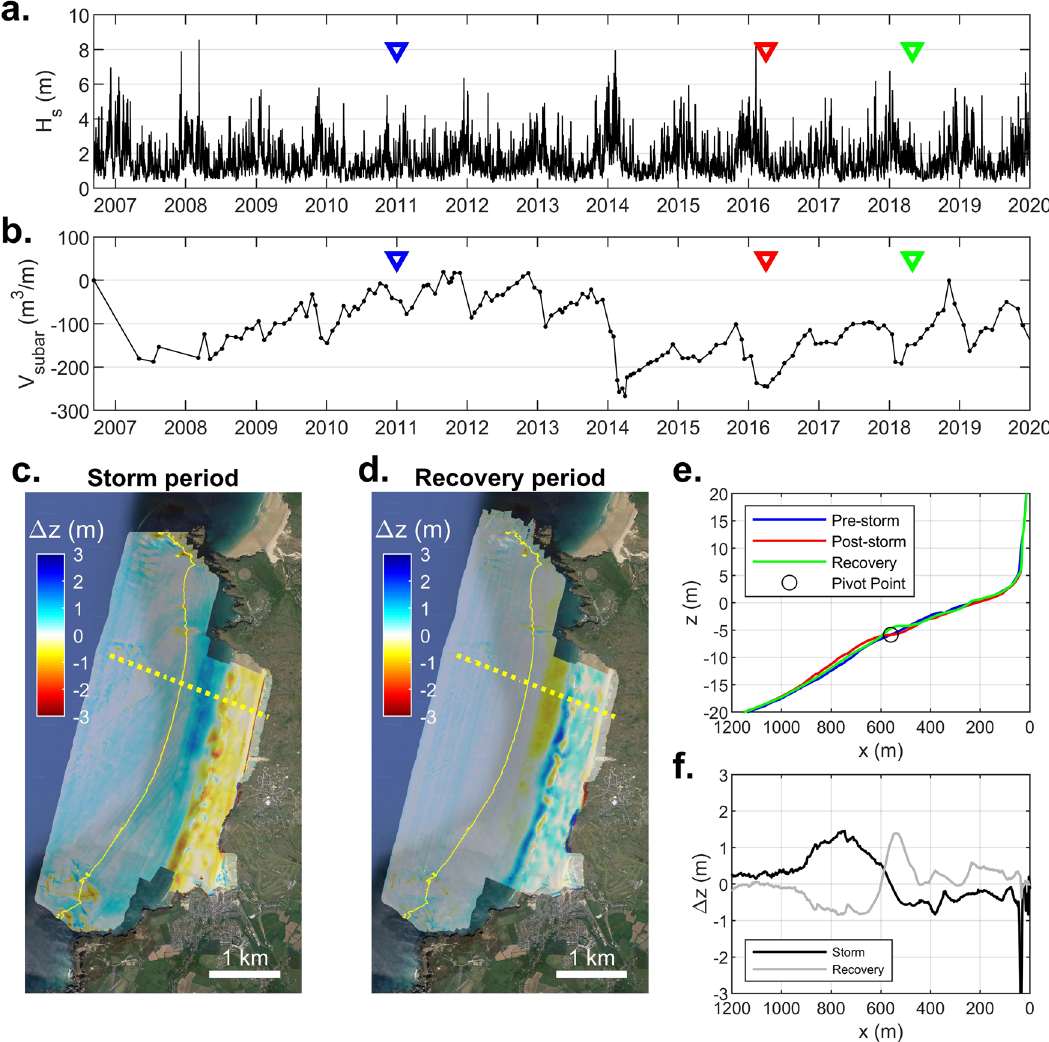
Fig. 4 Summary of wave and entire beach variability at Perranporth, UK. a Deep-water signi fi cant wave height for Perranporth spanning the period of long-term beach surveys (2006 – 2020). b Average subaerial volume change from beach surveys. Triangles in ( a , b ) represent the timing of pre-storm (blue), post-storm (red), and recovery (green) surveys. c Overall vertical change during the storm period; and d during the recovery period (Depth of Closure indicated by the solid yellow line). e A representative cross-shore transect indicating pre-storm, post-storm, and recovery morphology; and f the vertical change over these two periods. Note that the abrupt vertical change ( Δ Z < − 3 m) indicated during the storm period is due to frontal dune erosion caused by the storm sequence Basemap data in ( c , d ) ©2022 Google (Imagery ©2022